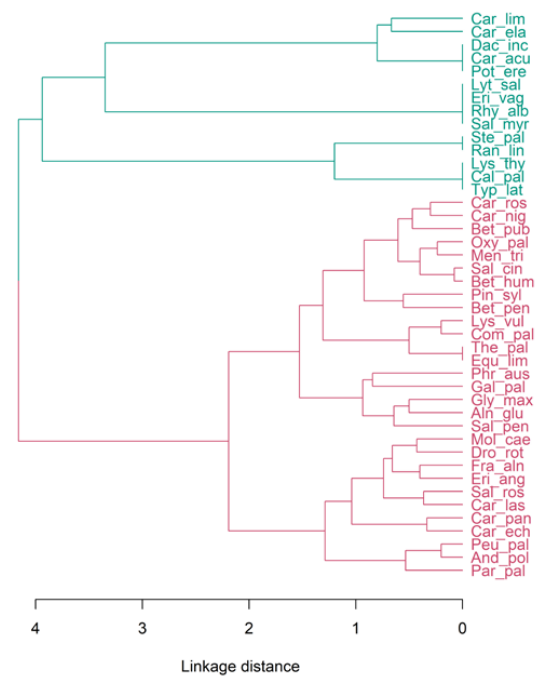
Figure 4. Dendrogram plot for species composition (taxonomic abbreviations from the first three letters of names of the genus and species of plants). Species composition of phytocoenoses (in alphabetical order): Alnus glutinosa , Andromeda polifolia , Betula humilis , Betula pendula , Betula pubescens , Calla palustris